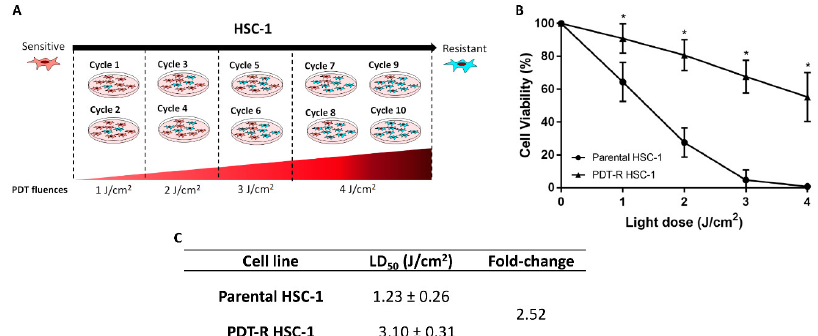
Figure 1. Generation of photodynamic therapy (PDT) resistance in HSC-1 cells. ( A ) The figure represents the workflow used to obtain a resistant population after 10 cycles of PDT. ( B ) Cell viability of parental HSC-1 cells compared to PDT-resistant HSC-1 cells at di ff erent light doses. ( C ) Lethal dose and fold-change index calculated for each cell line. Values of p < 0.05 were considered statistically significant. LD = Lethal dose; * p < 0.05. Data were expressed as mean ± SD of three biological